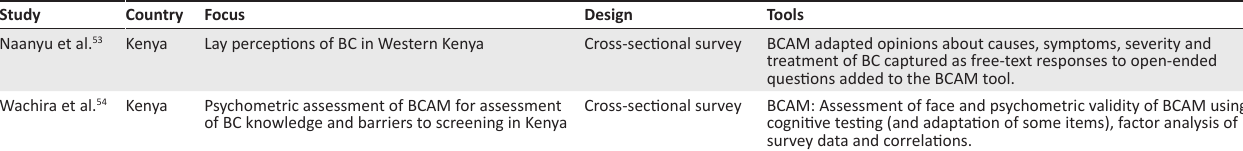
TABLE 3: Symptom awareness tools identified, thorough